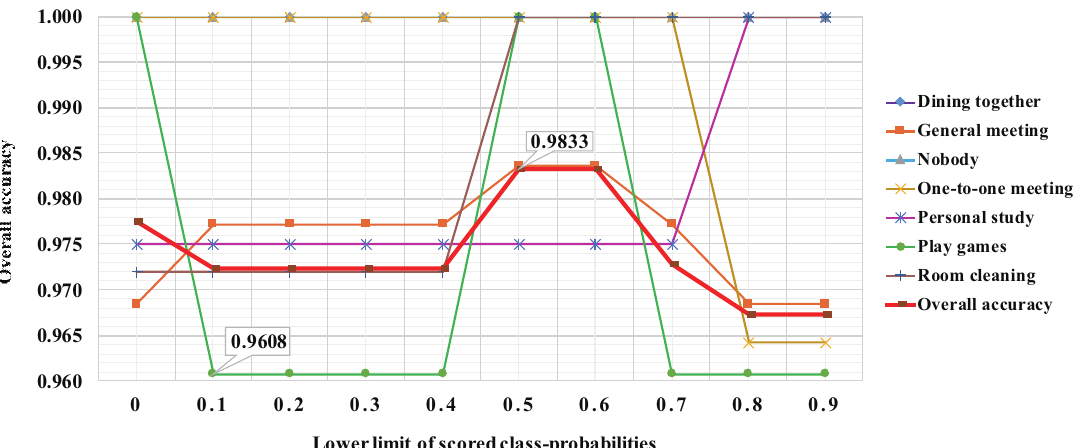
Figure 7. The distribution of accuracy results using range voting within the range 0 to